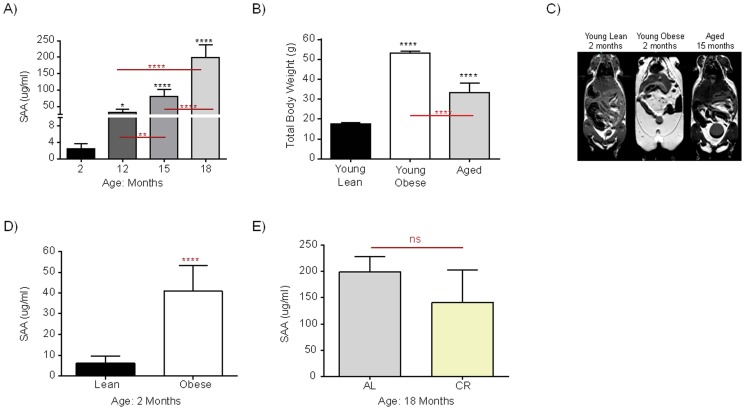
Serum SAA levels in C57BL/6 mice of 2, 12, 15, and 18 months of age (A). Total body weights were assessed for young lean, young obese (ob/ob), and aged mice (B). MRI images demonstrating distribution of fat deposits in young lean, young obese and aged mice (C). Serum SAA levels in young lean and age-matched young obese (2 months old) (D), and age-matched aged ad libitum-fed and calorie-restricted mice (18 months of age) (E). N = 3–13, *P<0.05, **P<0.01, ***P<0.001, ****P<0.0001.